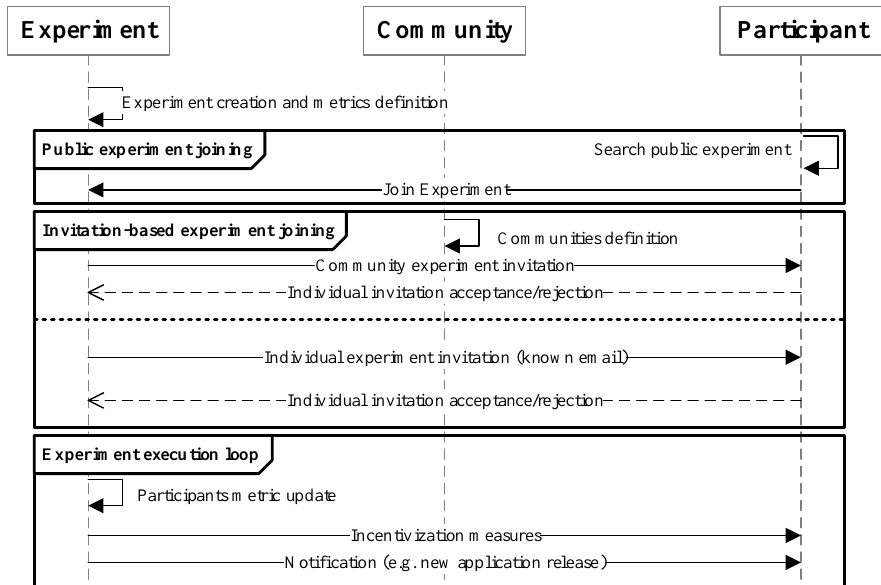
Figure 2. Overall OrganiCity experimentation